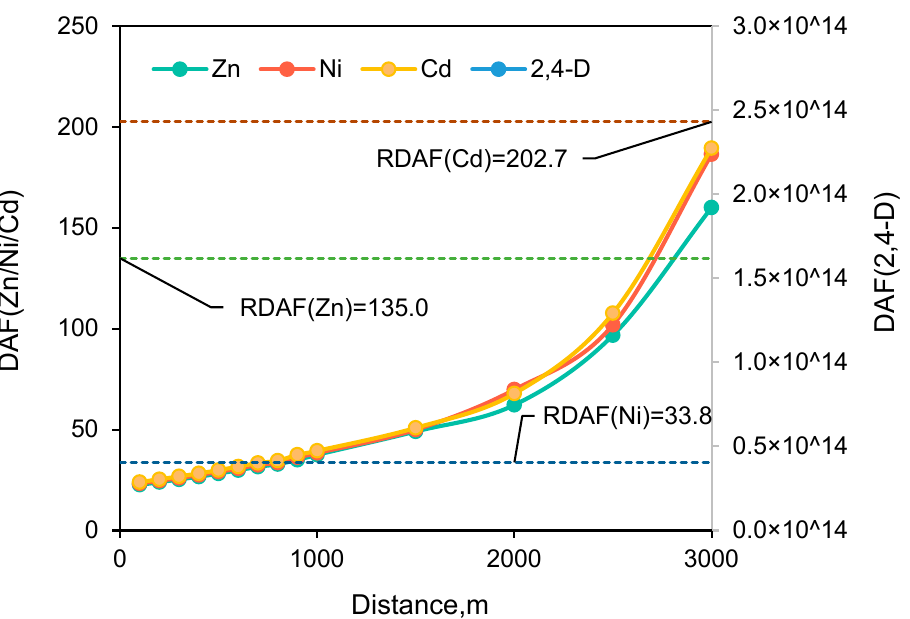
Figure 3. Dilution and attenuation of different contaminants at varying distances. Overall, the dilution and attenuation effects of subsurface media on contaminants in leachate increased with increasing buffer distance, However, the dilution and attenuation processes of different pollutants are sensitive to buffer distances to varying degrees. The dilution and degradation of heavy metal contaminants are relatively insensitive to buffer distance, while organic contaminants are more sensitive on buffer distance, and their dilution capacity increases with increasing buffer distance.